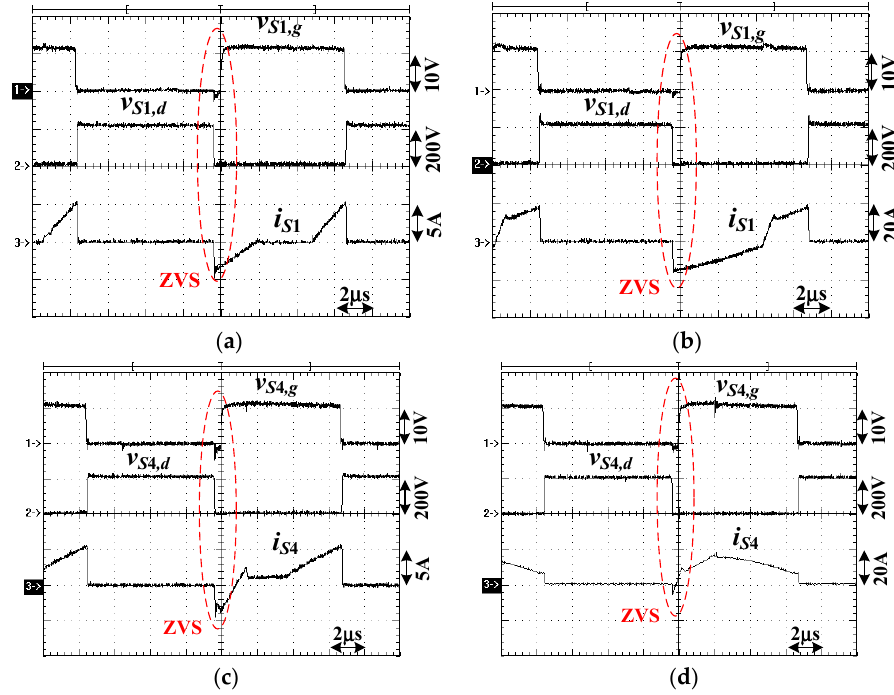
Figure 12. Measured results of S 1 and S 4 at V in = 210 V input ( a ) S 1 waveforms at 160 W (20% load)